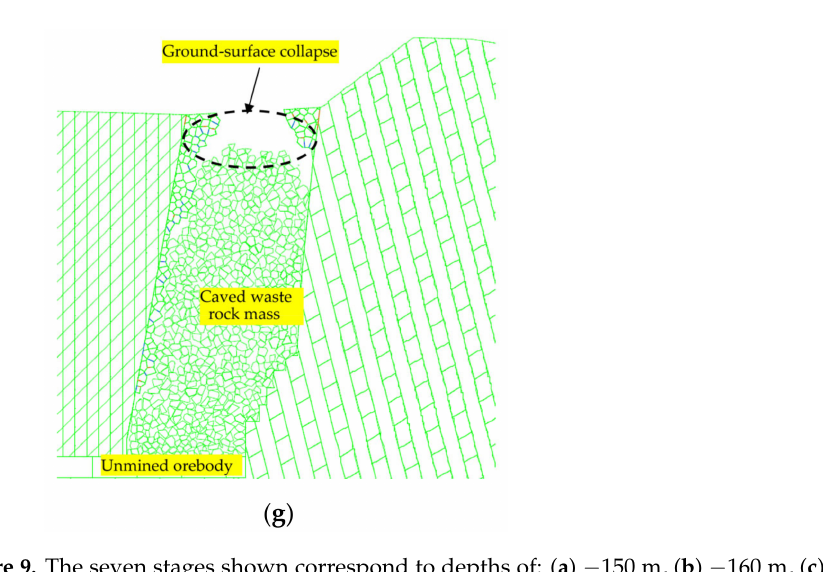
Figure 9. The seven stages shown correspond to depths of: ( a ) − 150 m, ( b ) − 160 m, ( c ) − 171.5 m, ( d ) − 183 m, ( e ) − 194.5 m, ( f ) − 206 m, and ( g ) − 218 m. Red lines denote tensile failure; blue lines denote shear failure.